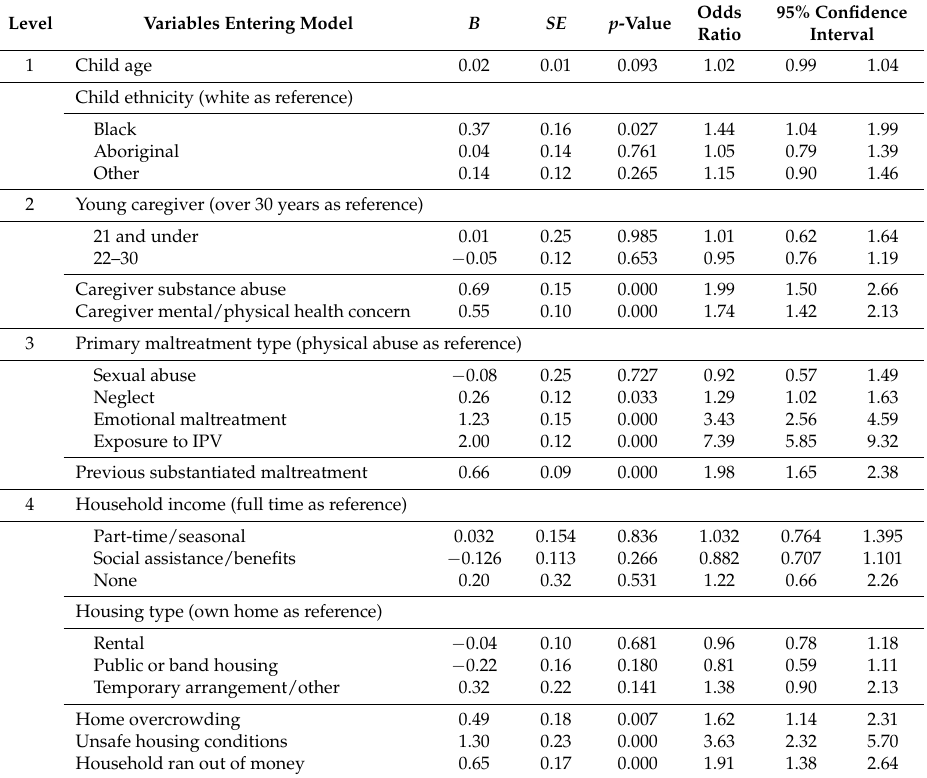
Table 4. Multiple logistic regression predicting substantiation of maltreatment in maltreatment